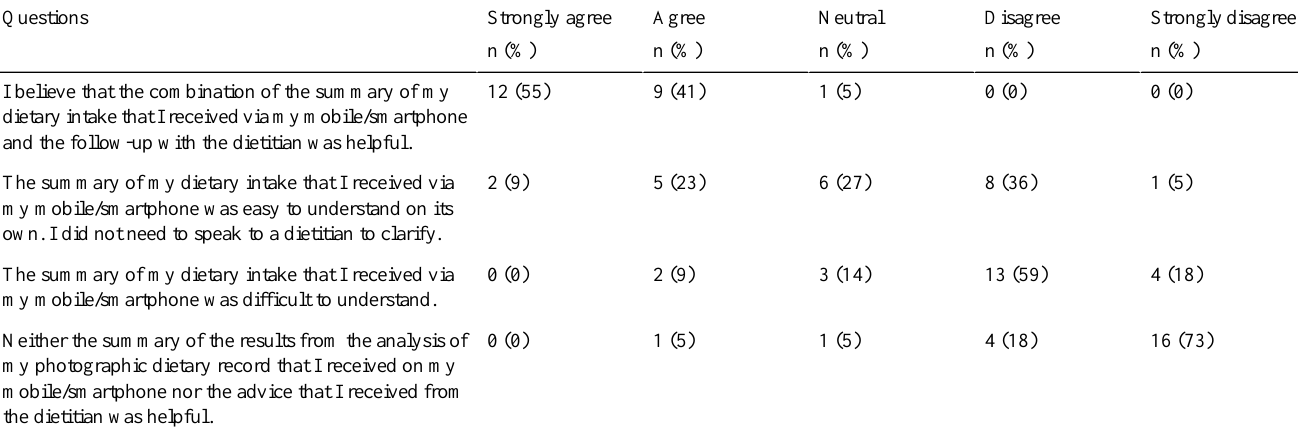
Table 3. Participant’s perceived acceptability for receiving dietary counselling in the Diet Bytes and Baby Bumps study (n=22 a ) (survey questions with agree-disagree responses).